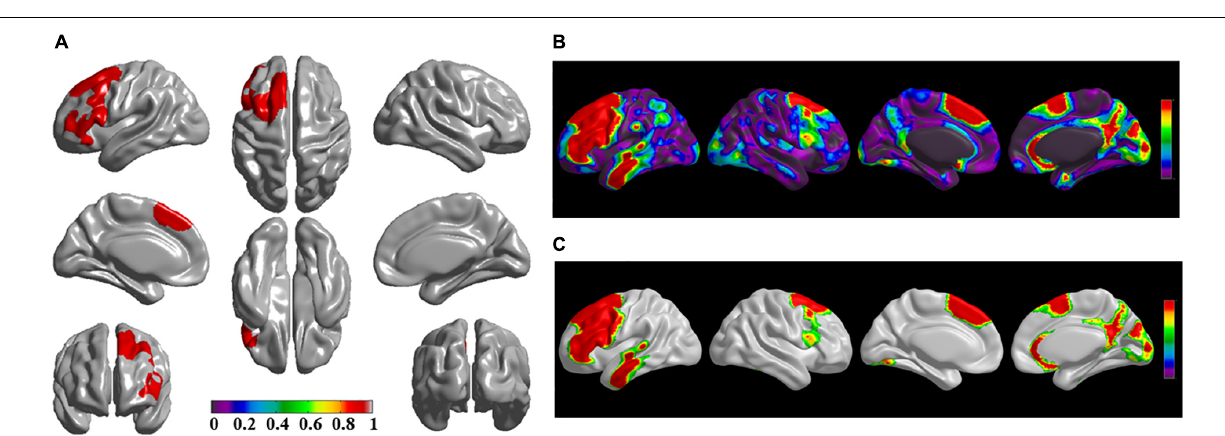
FIGURE 4 | The significantly altered brain regions of cortical structural connectivity in the sPD brain based on seed 4. (A) The brain regions of seed 4, the red brain regions represent the cortical thickness thinning regions. (B) The significantly altered brain regions in the F-map based on seed 4, the red, and green brain regions represent the brain regions of significant cortical structural connectivity alteration that were not corrected by the FWE. (C) The significantly altered brain regions after FWE correction based on seed 4, the red and green brain regions represent the brain regions of significant cortical structural connectivity alteration that were corrected by the